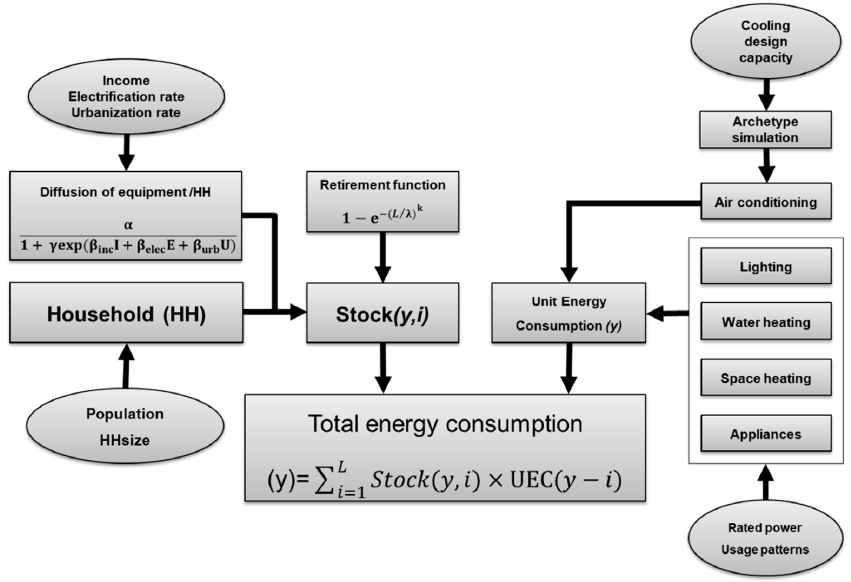
Figure 4. End-use energy consumption model structure.